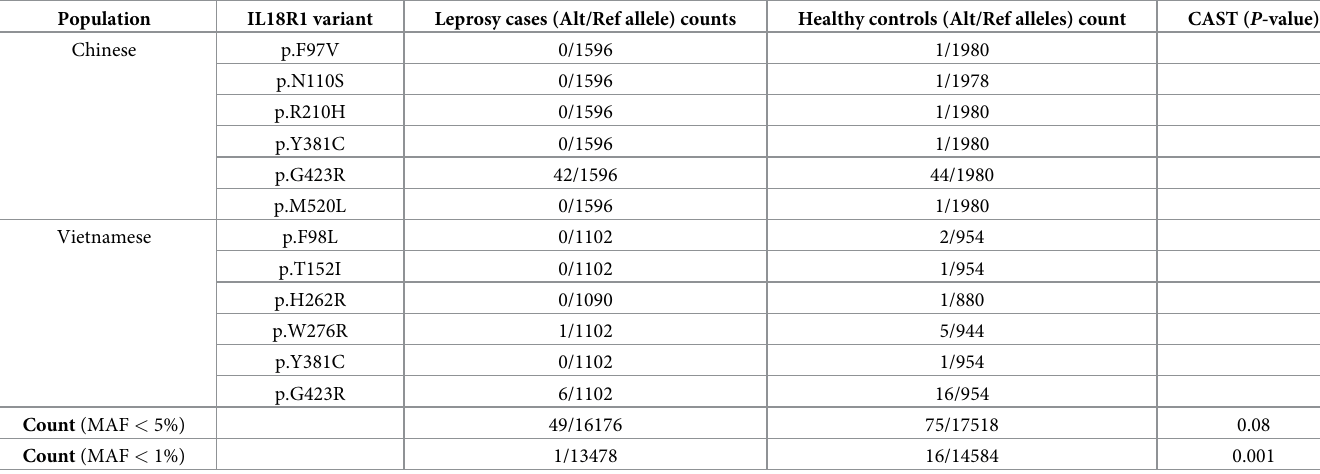
MAF; minor allele frequency. Alt; Alternative allele. Ref; Reference allele. CAST estimate differences in the cumulative allelic frequency between cases and controls by combining listed variants in a “super variant”. The bottom two rows show the cumulative allelic count for variants with MAF < 5% or MAF < 1% used as threshold for inclusion in CAST